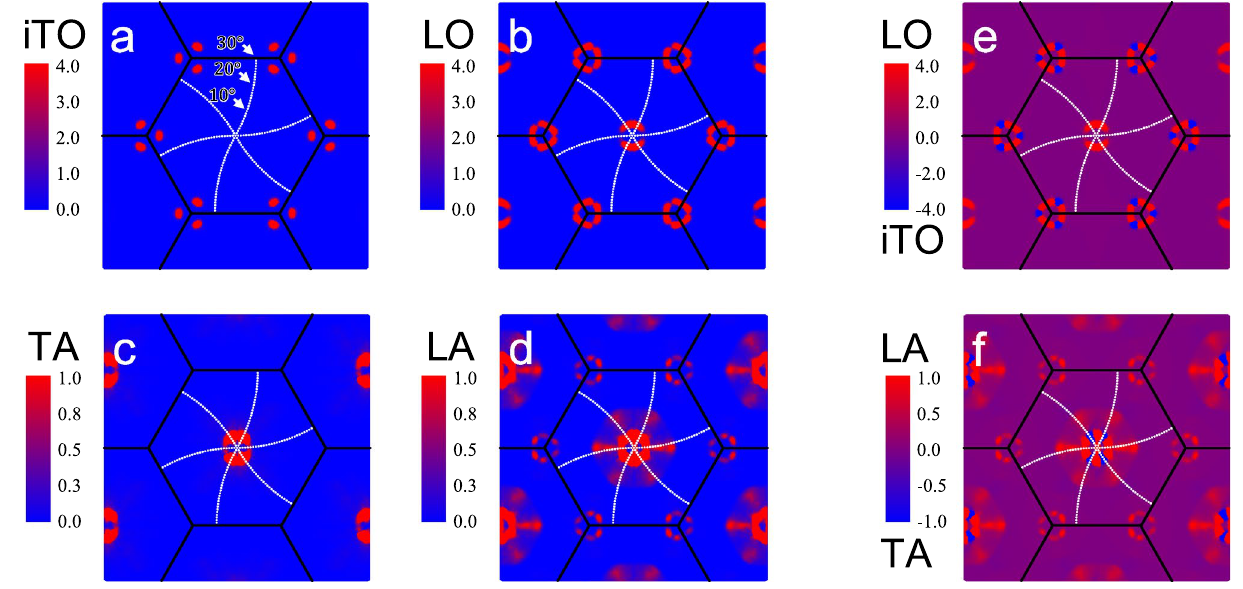
Figure 4. ( a – d ) Theoretical double-resonance Raman intensity ˜ I ν ( q ) in graphene as a function of the phonon wave vector q for the iTO, LO, TA and LA branches, calculated without the restriction q = q M . The white dotted lines in these figures represent the Moiré vector q M paths as function of the twisting angle, being θ 30 Ŵ point and θ ◦ at the middle point between K and M . ( e – f ) Differences between ˜ = transverse